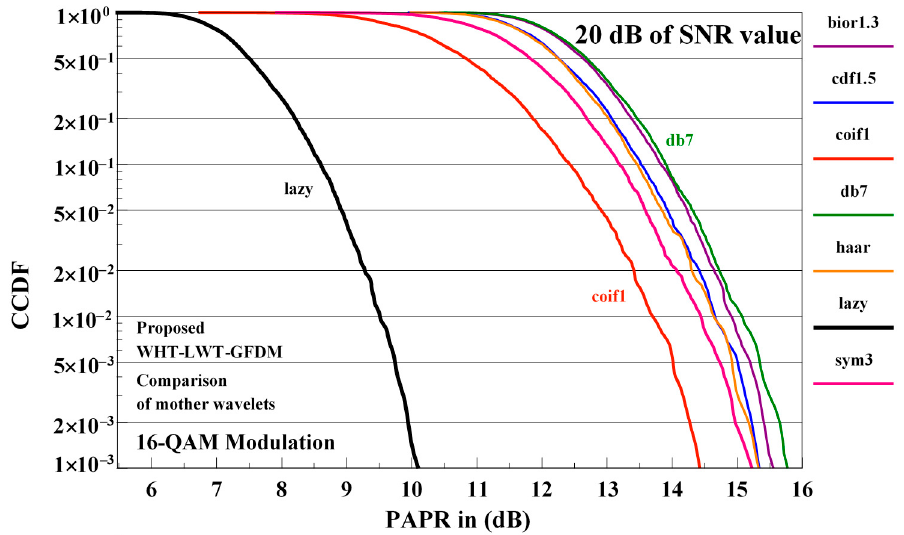
Figure 14. The influences of the different mother wavelets on PAPR performance of proposed waveform in 20 dB of SNR value for 16-QAM modulation.